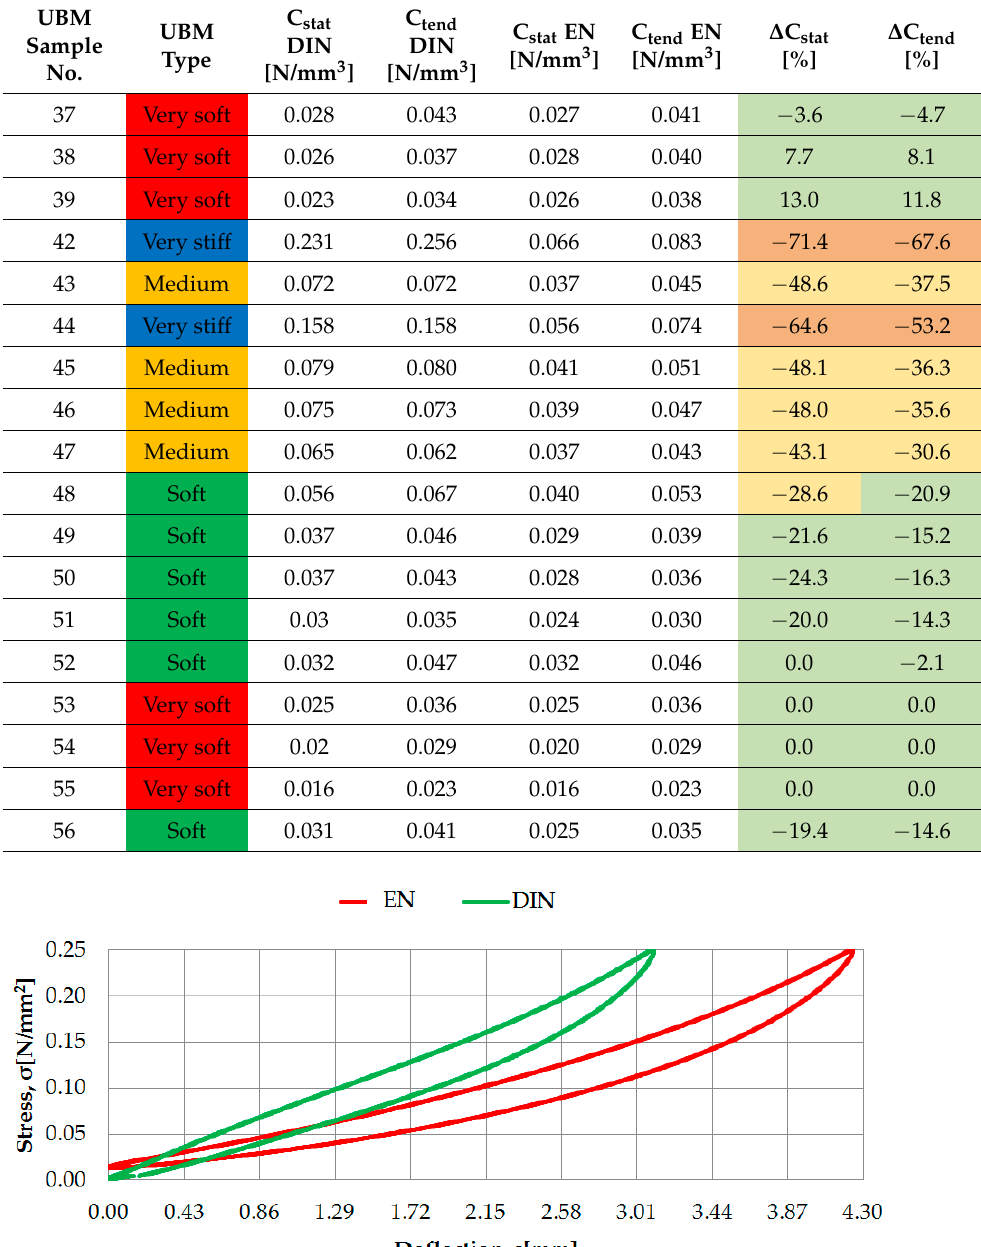
Table 8. Static bedding moduli of UBM according to DIN [23] and EN [24].